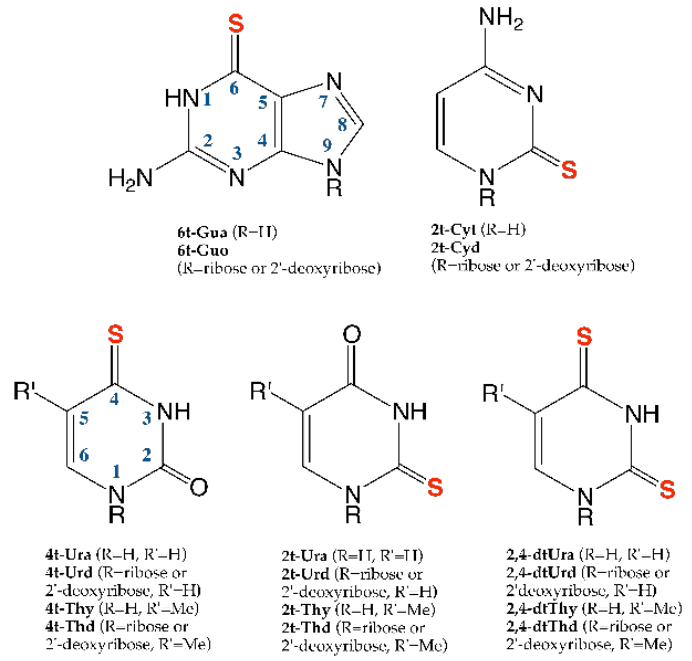
Figure 2. Potential energy profiles for 6t-Gua ( Left ) and 2t-Cyt ( Right ) inferred from quantum mechanical studies. Energies in eV relative to the ground state. For 6t-Gua, underlined energies were taken from Ref. [58]. The rest were extracted from Ref. [55]. For 2t-Cyt, energies were taken from Ref. [34]. The double well profile of T 1 is based on Ref. [59].